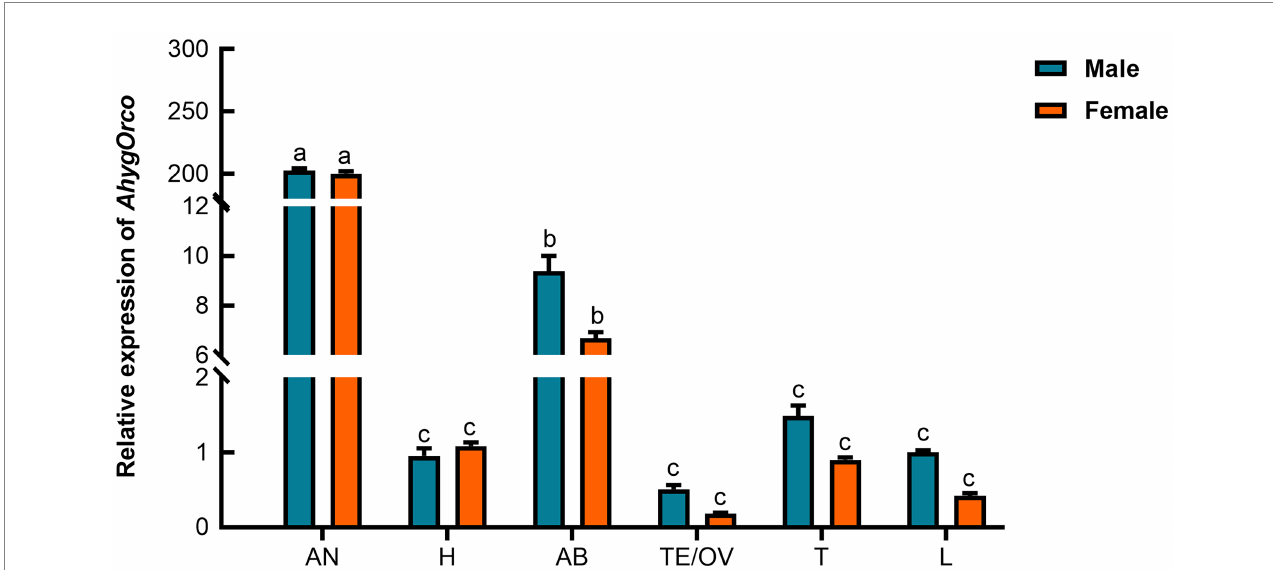
FIGURE 4 Expression profiling of AhygOrco in different tissues of male and female beetles. All expression fold changes were related to the leg of the male. AN: antennae, H: heads without antennae, AB: abdomens, OV: female ovaries, TE: male testes, T: thoraxes, L: legs. Bars with the same letter are not significantly different from each other at the p < 0.05 level based on Tukey’s test. Each point represents the mean ( n = 3) ± SEM. ( F 11,24 = 9752.504, p < 0.001).